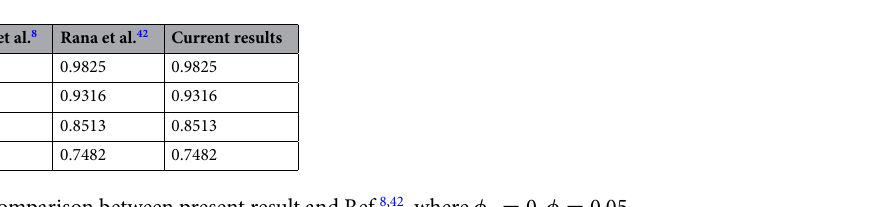
Table 2. Comparison between present result and Ref. 8,42 , where φ a = 0, φ = 0.05 .